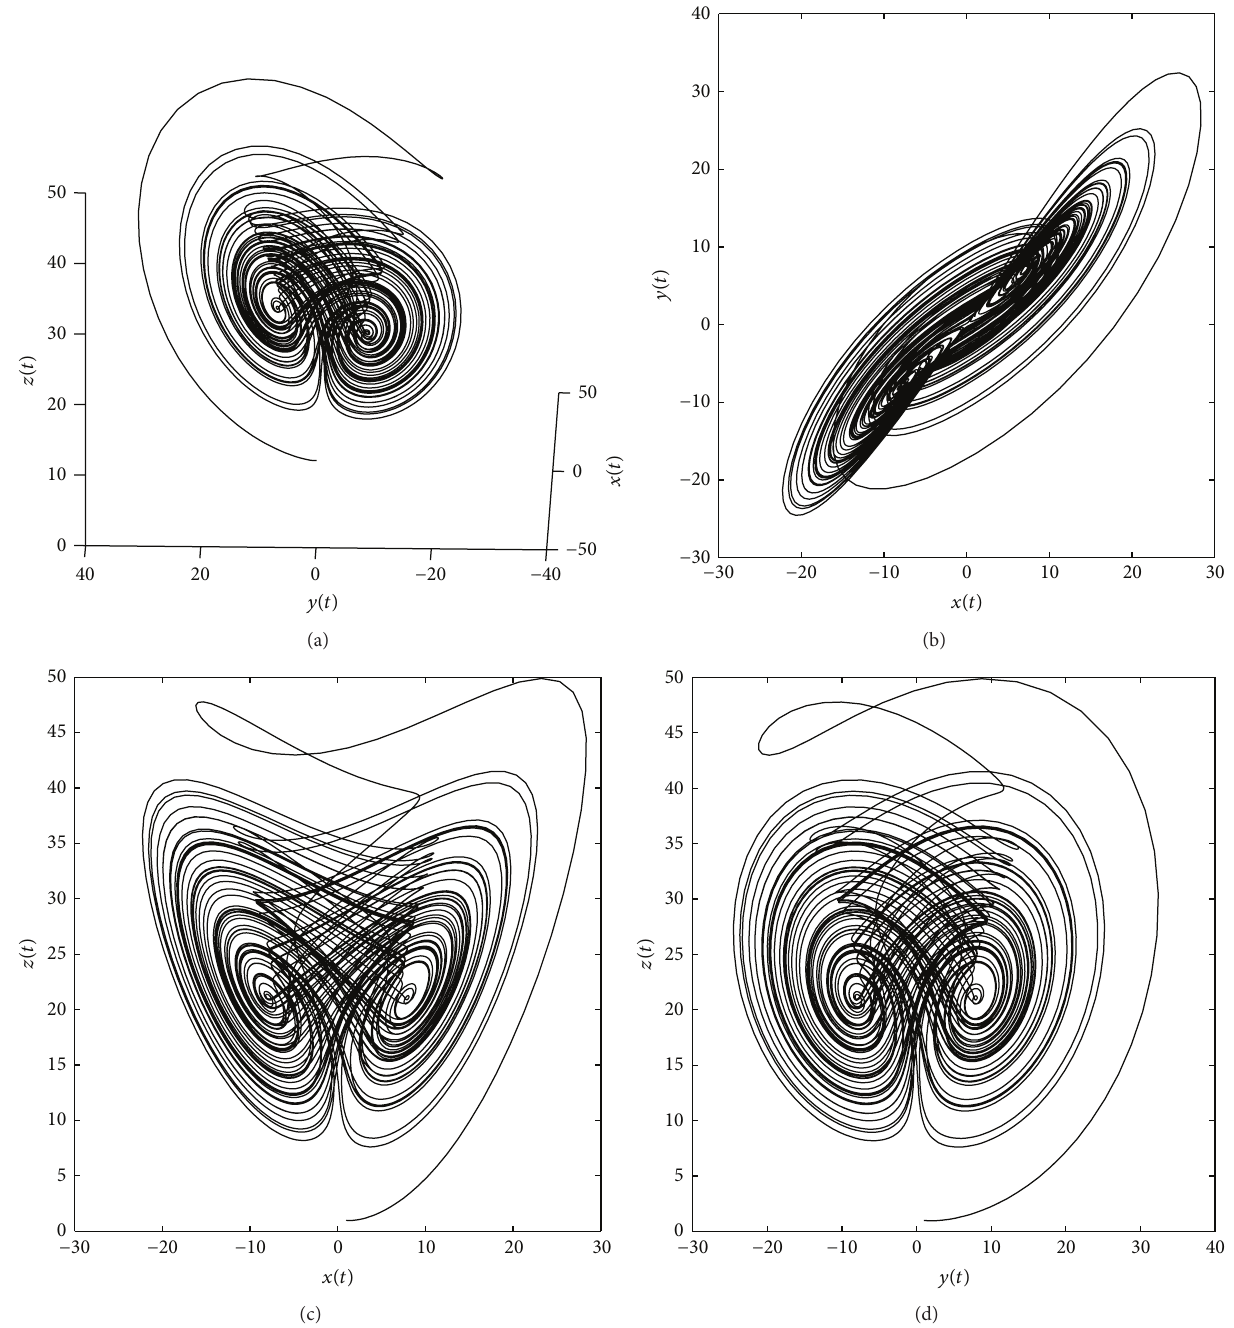
Figure 1: Chaotic attractor of the integer-order Chen system (21) with (𝑎,𝑏, 𝑐) = (35, 3, 28) .